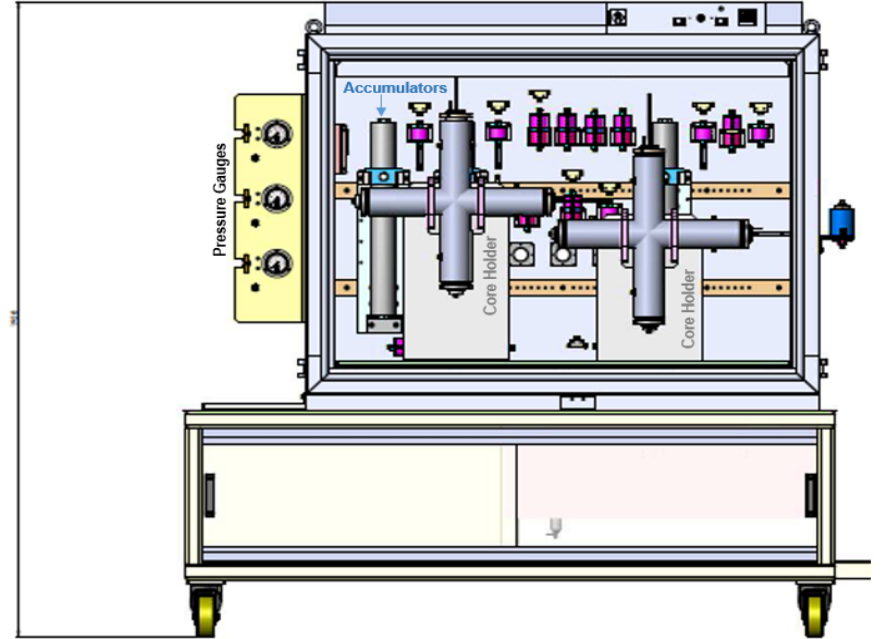
Figure 1. Schematic of coreflooding machine with Hastelloy wetted